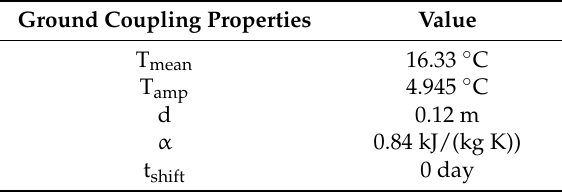
Table 2. Ground Coupling Properties.